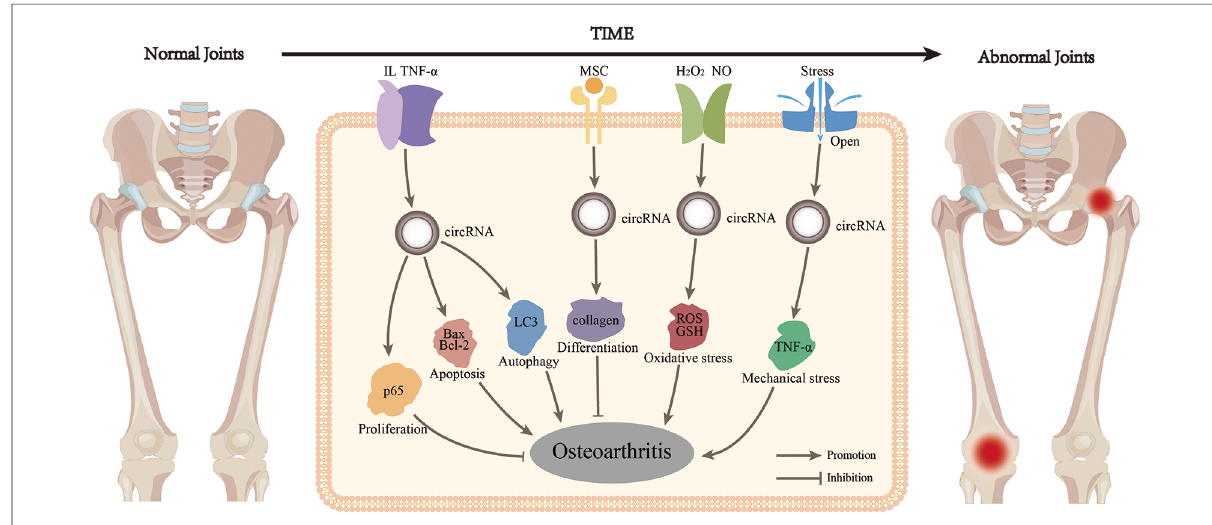
FIGURE 2 CircRNA regulates multiple phenotypes of OA in several ways. CircRNA activated by in fl ammatory factors could participate in proliferation, apoptosis and autophagy, thus regulating OA. CircRNA could also participate in the process of OA through differentiation, oxidative stress and mechanical stress